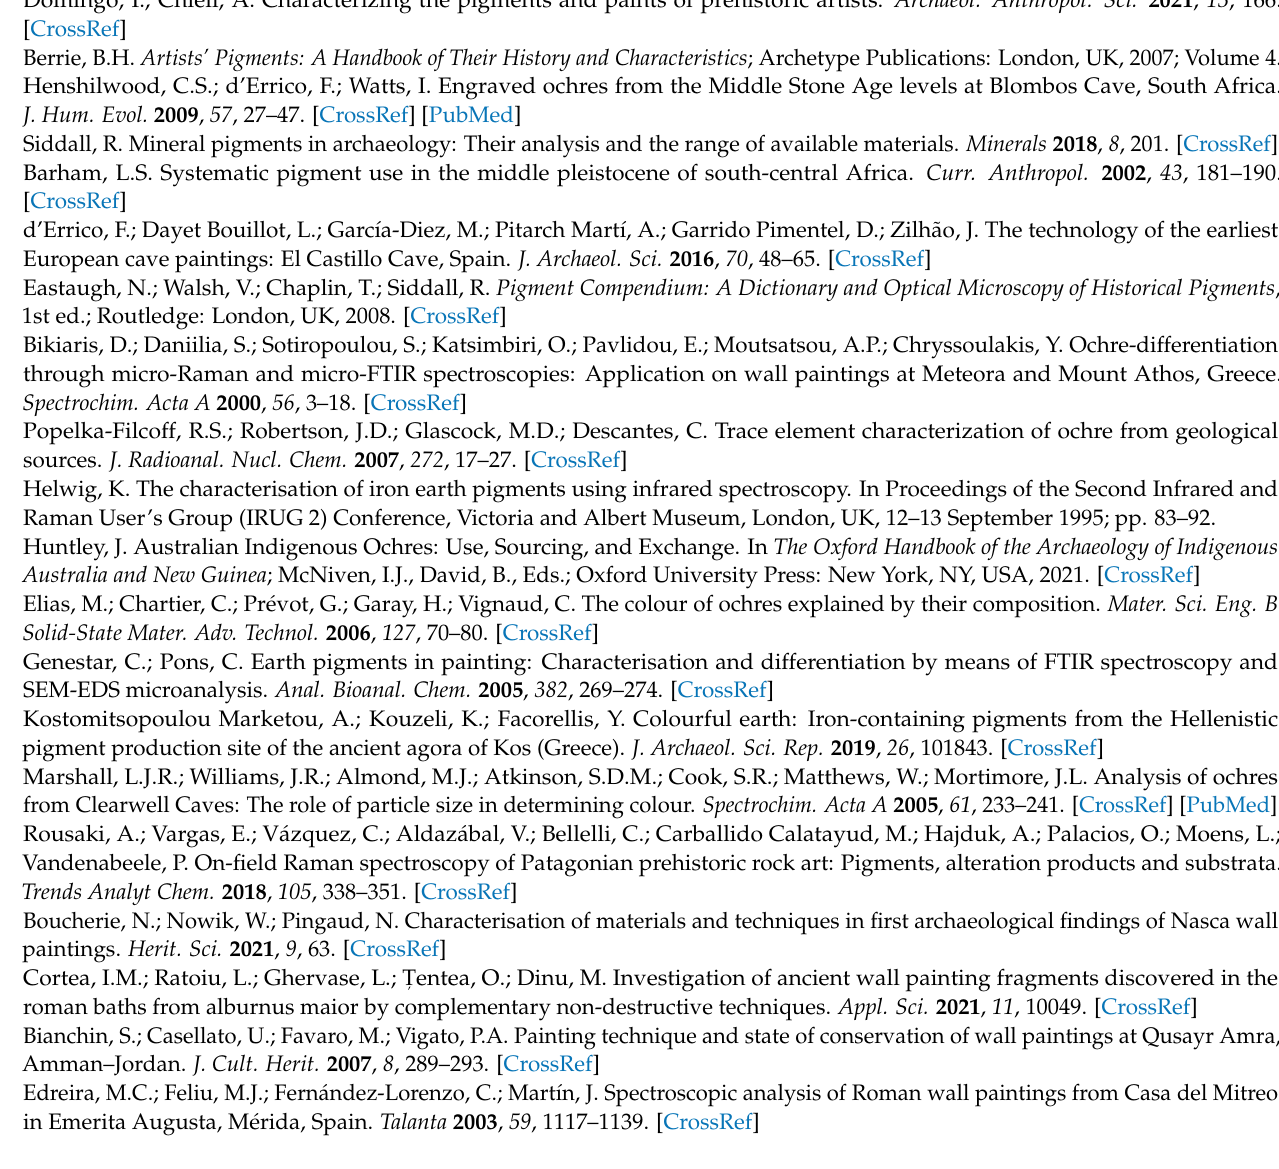
pigments. Figure S2. Raw XRF data (full data set). Figure S3. Raw Raman data (785 nm). Figure S4. Loading plots